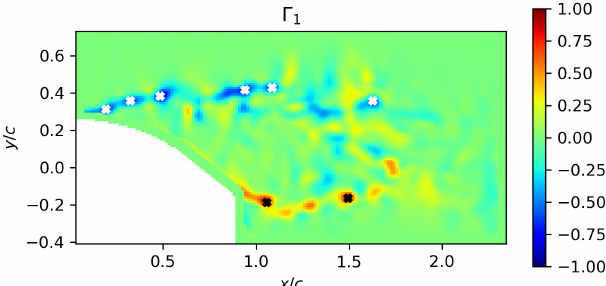
Figure 6. Example of an instantaneous isocontour map of the (cid:48) 1 field with peaks identified using white cross markers for clockwise vortices and black cross markers for counterclockwise